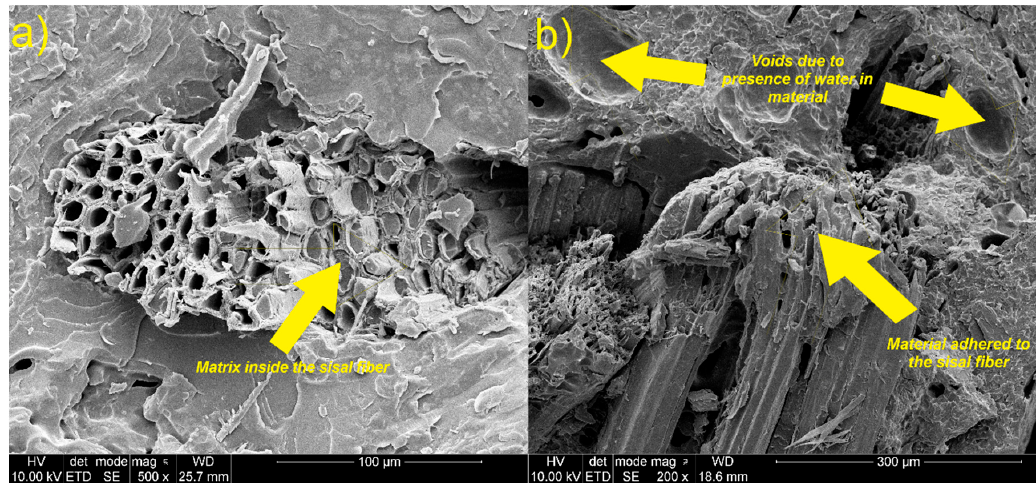
Figure 16. SEM images of sisal fiber in composite, ( a ) transversal crack of sisal fiber in the material; ( b ) the longitudinal crack of sisal fiber in the material.